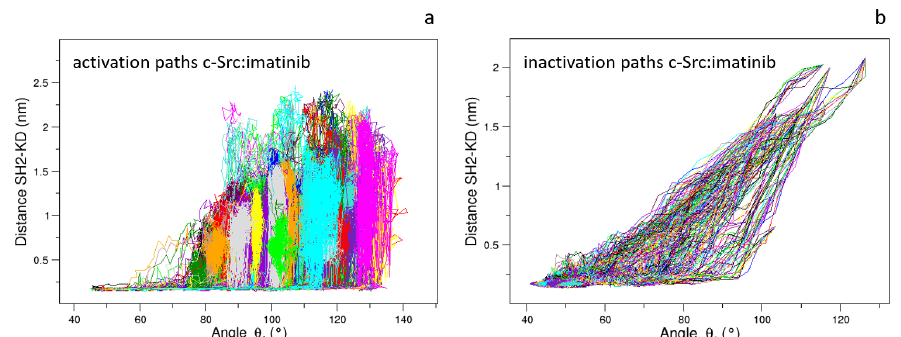
Figure 13. Evolution of the distance d DR vs. angle θ K 23 as observed in the c-Src:imatinib EDS trajectories for the activation ( a ) and inactivation processes ( b